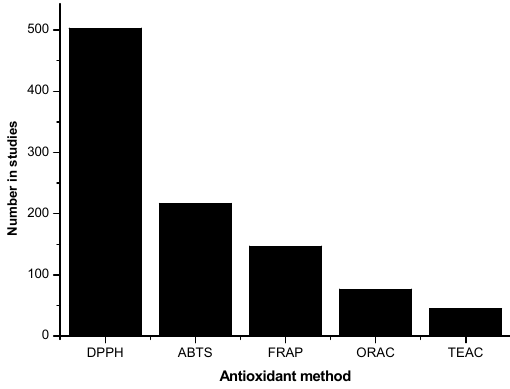
Figure A2. Number of studies in 2016 identifying antioxidant activity method.